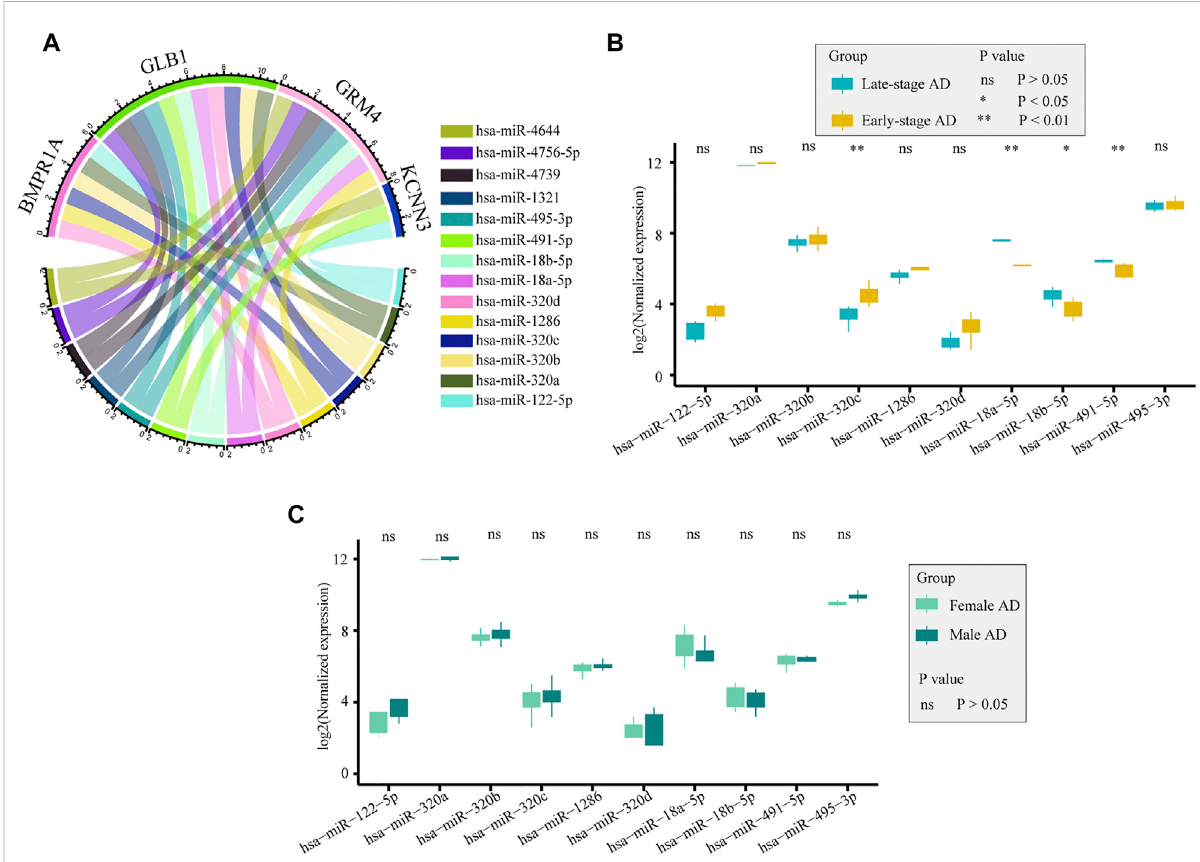
FIGURE 10 Potential miRNAs regulated selected genes. (A) . Potential miRNAs regulating selected genes were obtained from the ENCORI database. (B) . Expression of miRNAs between early-stage and late-stage ADs from GSE48552: hsa-miR-320c , hsa-miR-18a-5p , hsa-miR-18b-5p , and hsa-miR- 491-5p were differentially expressed between the two groups. (C) . Expression of miRNAs between females and males ADs from GSE48552: no signi fi cant difference was detected between the two